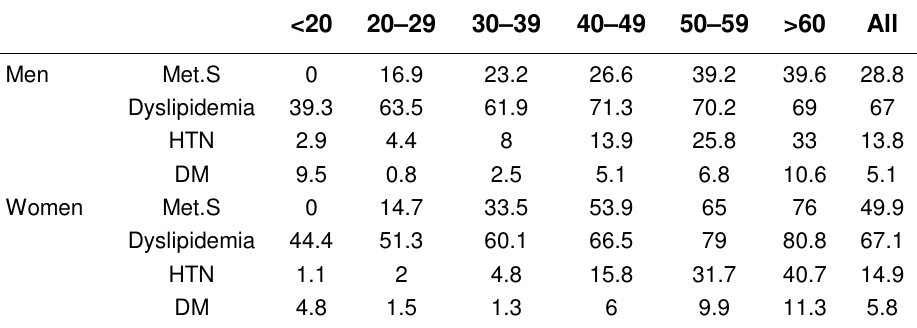
Prevalence (%) of Multiple Risk Factors in Different Gender and Age Groups